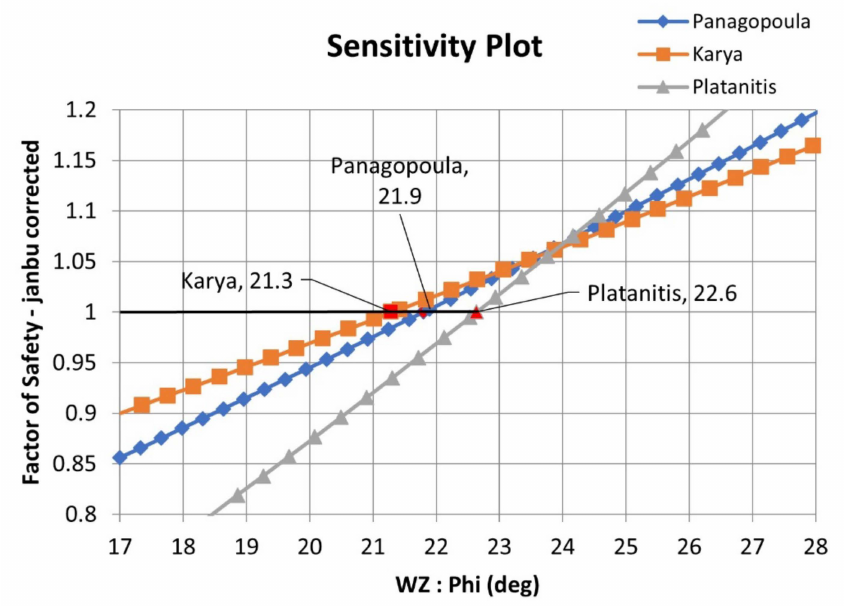
Figure 11. Sensitivity plot of the angle of friction of the three studied landslide